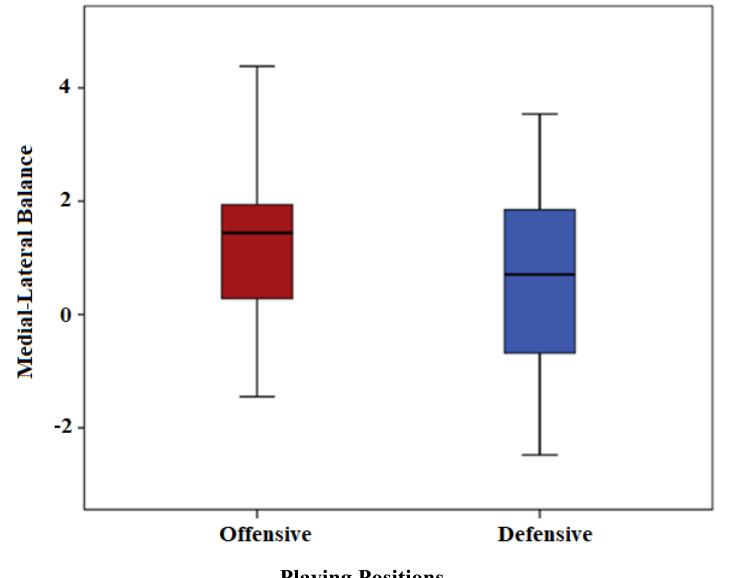
Playing Figure 9 . Comparison of Medial-Lateral Balance ( o ) of players according to playing positions